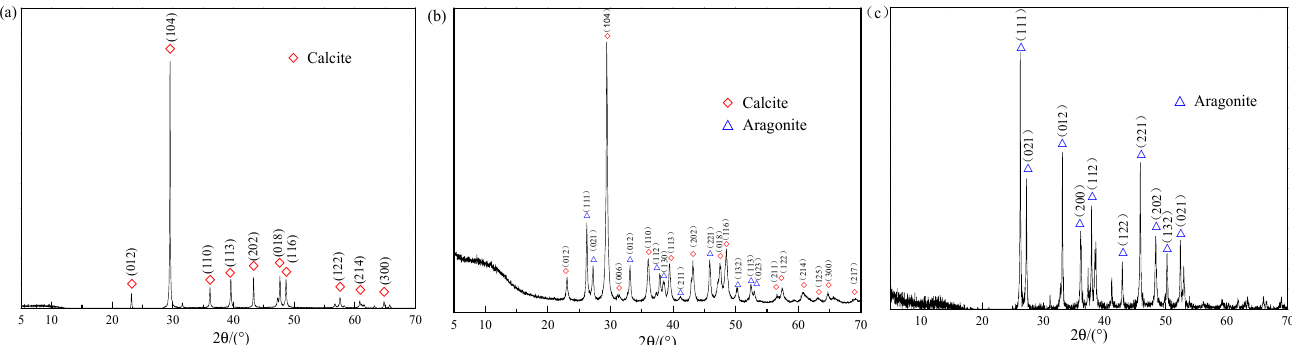
Figure 2. XRD patterns of shell bio-fillers. ( a ) CES; ( b ) CHS; ( c ) CMS. The morphologies and compositions of CES, CHS, and CMS are presented in Figure 3. As seen in Figure 3, all the bio-fillers show an irregular blocky structure with a rough surface, and the size is mainly distributed in the range of 1–20 μ m. By combining EDS results, it can be found that all the shell fillers mainly consist of Ca, O, and C elements, where there is a slight difference in content of Ca element. Figure 3. SEM images and EDS maps of shell bio-fillers. The TG curves of CES, CHS, and CMS are shown in Figure 4. As observed from Fig- ure 4, the pyrolysis process of shell bio-fillers is mainly divided in two stages in the tem- perature ranges of 100–550 °C and 550–900 °C. The mass loss at 150–550 °C is attributed to the decomposition of organic matter, and the mass loss at 550–900 °C is assigned to the decomposition of calcium carbonate. Specifically, CES showed a higher mass loss at 150– 550 °C due to the organic matter rich in CES. The char residues of CES, CHS, and CMS samples at 900 °C are 50.0%, 52.0%, and 55.8%, respectively, where CMS exerts the highest residual weight.